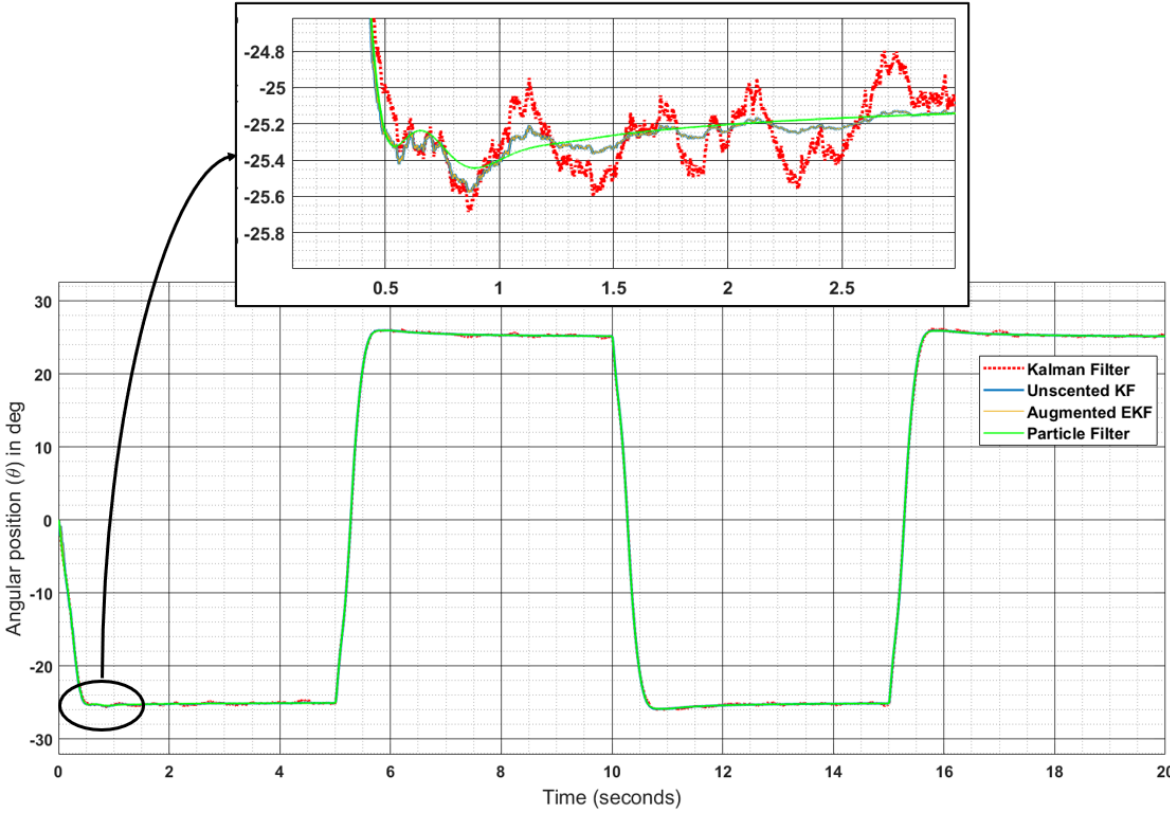
Figure 13. Comparison of filter responses with fractional order control for Link